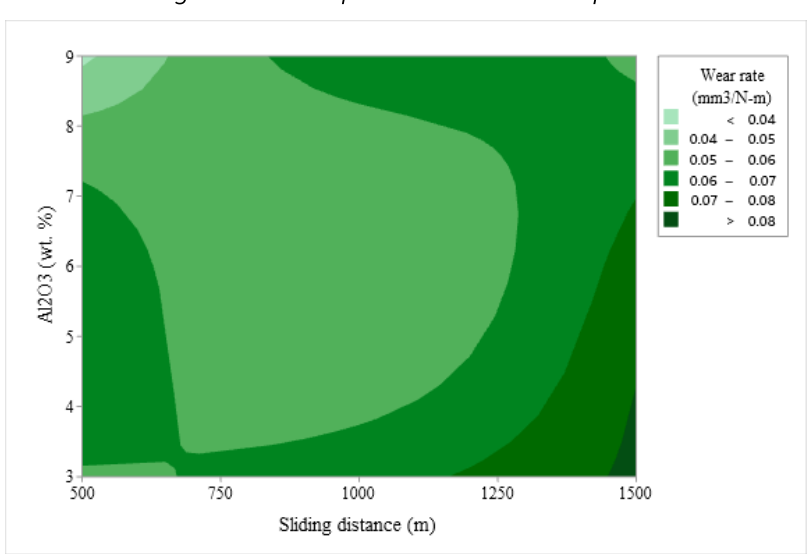
Fig. 6. Contour plot for wear rate vs. Al 2 O 3 (wt. %) and sliding